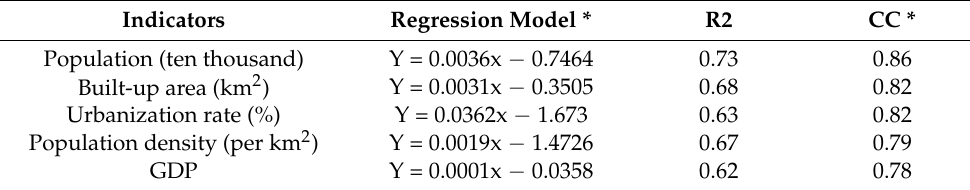
Table 2. Linear regression analysis of the UHII and urban development